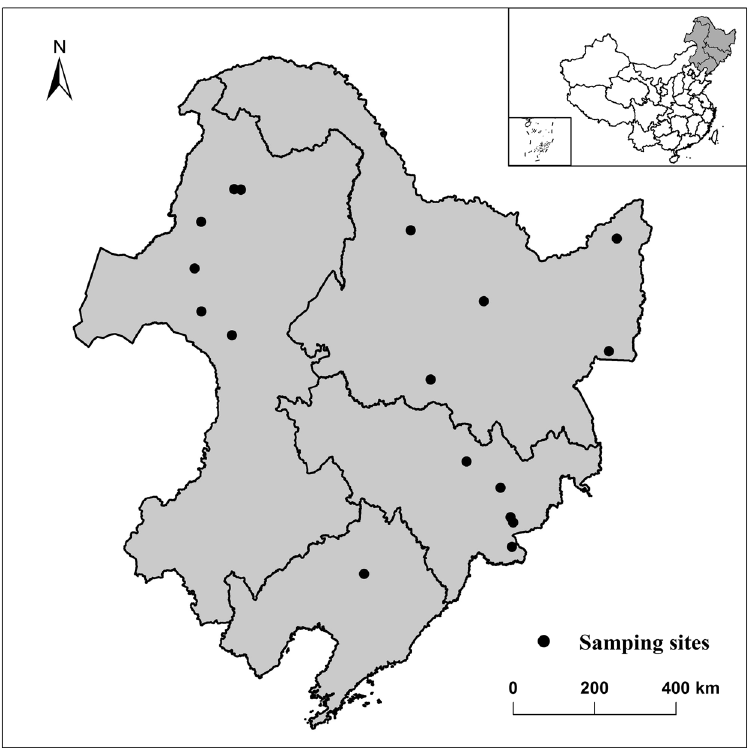
Figure 2. The distribution map of collection sites. The map is generated using software ArcGIS 10.3 (http:// www.esri.com/software/arcgis) based on the geospatial data from the National Geomatics Center of